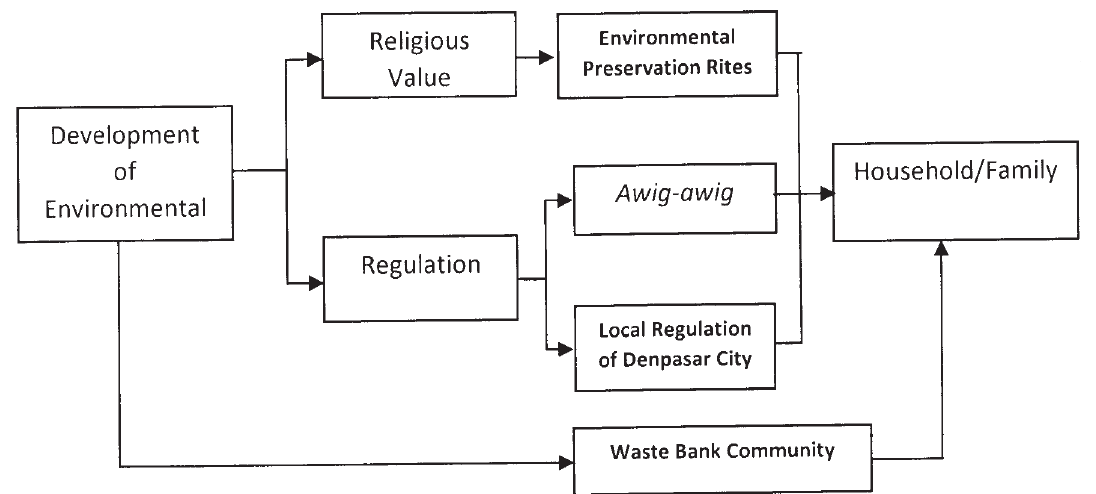
Figure 1 Development of Environmental Awareness Character of Padangsambian